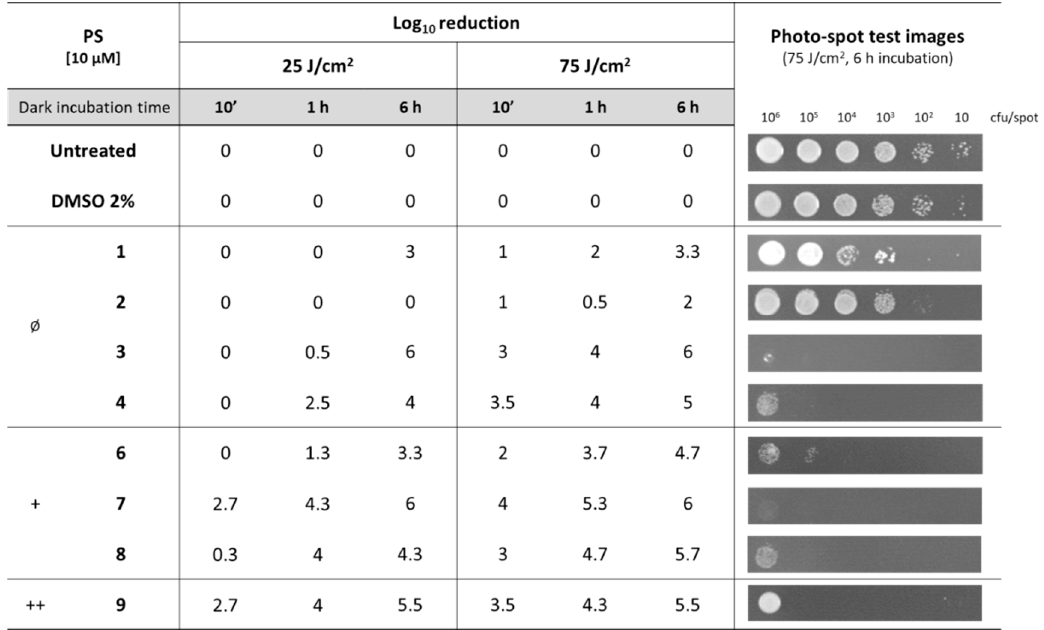
Figure 4. Photodynamic inactivation of Candida albicans by the photo-spot test with the diaryl-porphyrins ( 1 – 9 ). The neutral (Ø), monocationic (+), and dicationic (++) porphyrins were administered at a concentration of 10 µM. Values of Log 10 reduction were observed after irradiation with 410 nm of blue light at radiant exposures of 25 and 75 J/cm 2 , after increasing dark incubation periods (10 min, 1 h, and 6 h). Data are the mean of at least three independent experiments. Representative photo-spot pictures upon 6 h of dark incubation and 75 J/cm 2 irradiation are illustrated in the last column.